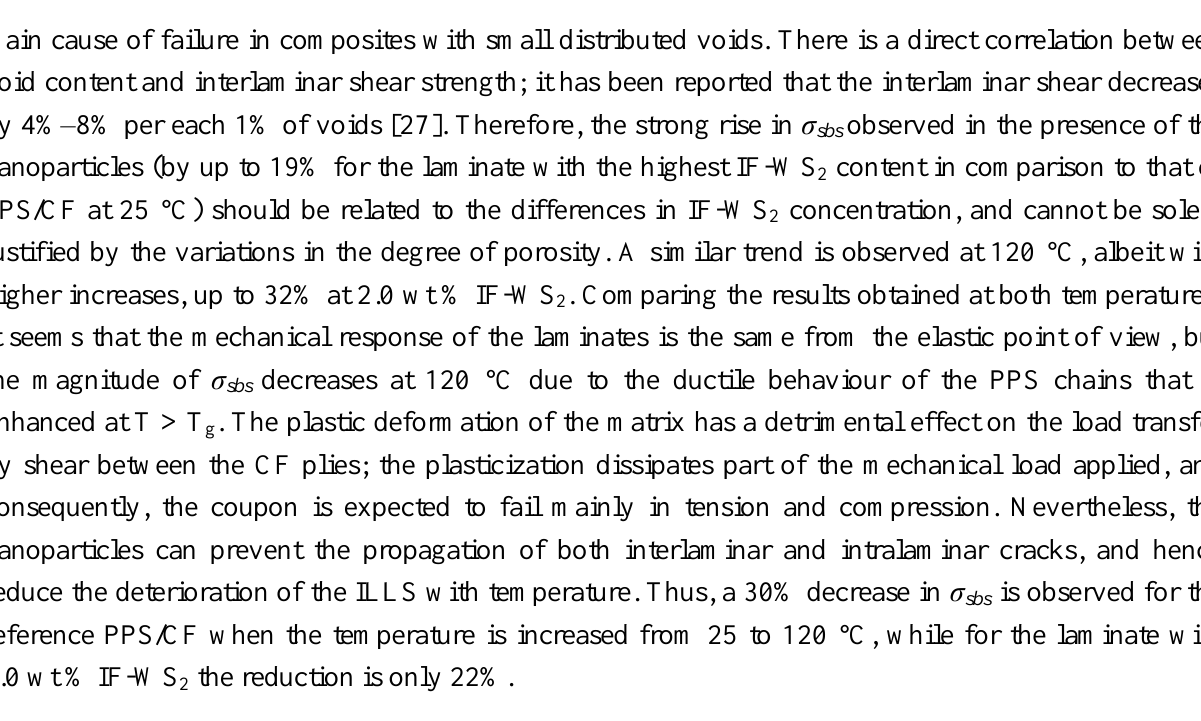
of PPS based laminates at sbs